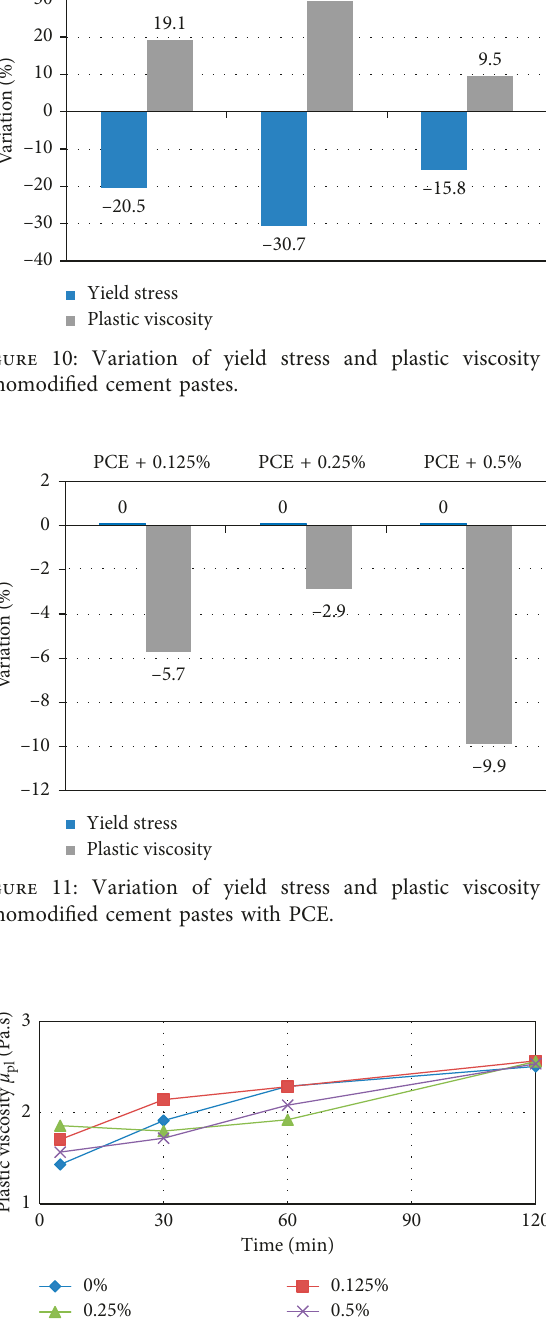
Figure 12: Variation of plastic viscosity of nanomodified cement pastes within 120 min duration.